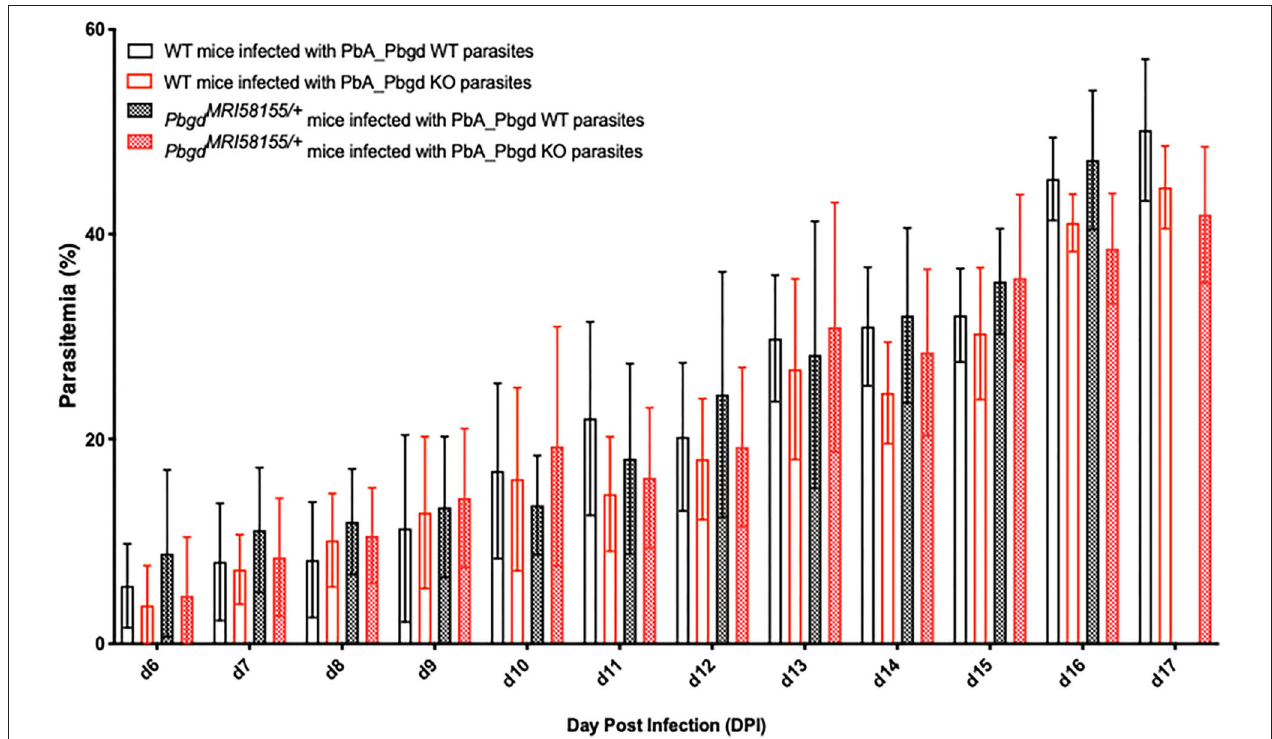
FIGURE 3 | Parasite growth analysis of wild-type and Pbgd -knockout P. berghei in wild-type and Pbgd MRI 58155 / + deficient mice. Blood parasitemia determined in WT and Pbgd MRI 58155 heterozygous (Het) mice after infection with either Pbgd -knockout P. berghei ( PbA_Pbgd KO) or parental wild-type (WT). For parasite lines the starting inoculum was 1 × 10 4 parasites. The data represent the mean ( + /– SD) for 8–15 mice per group. Data per group). growth in infected WT and Pbgd MRI 58155 heterozygous mice. There were no statistically significant differences comparing the four different parasite and animal combinations on each day of the infection using two-way